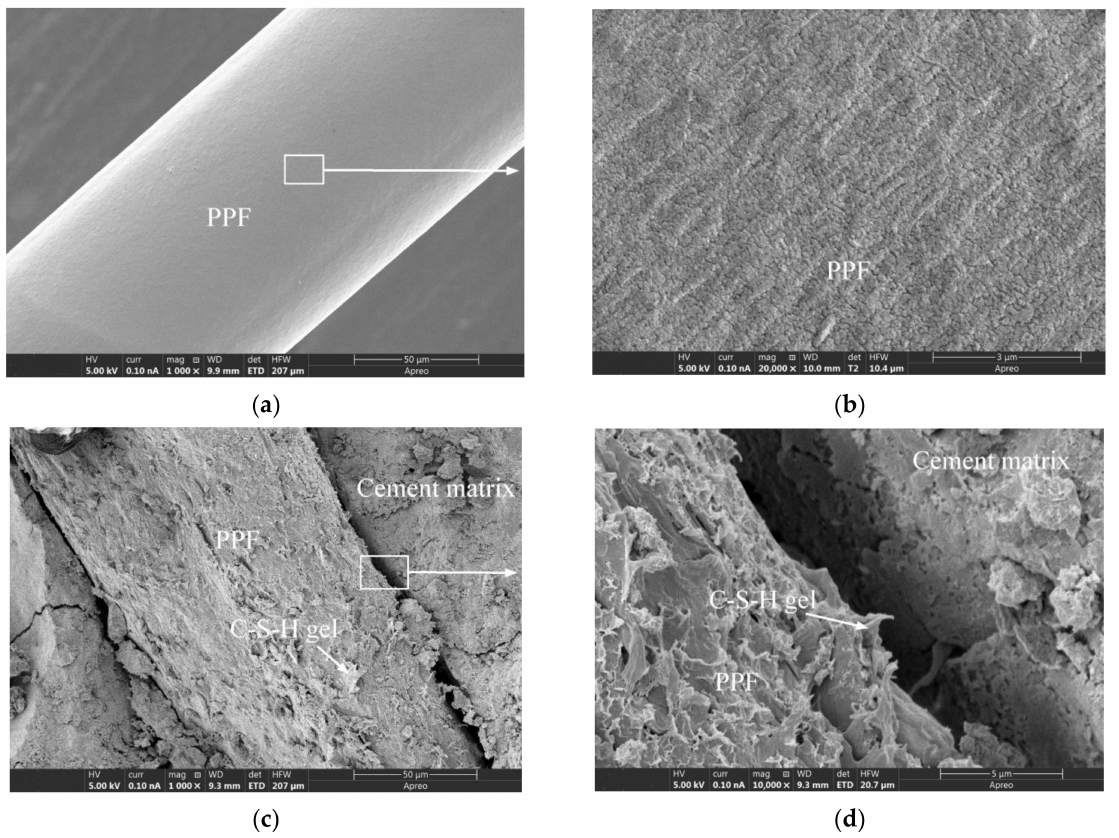
Figure 12. The SEM images of PPF and PPFRC specimens: ( a ) The unused PPF; ( b ) The unused PPF; ( c ) PPF-35-90; ( d )